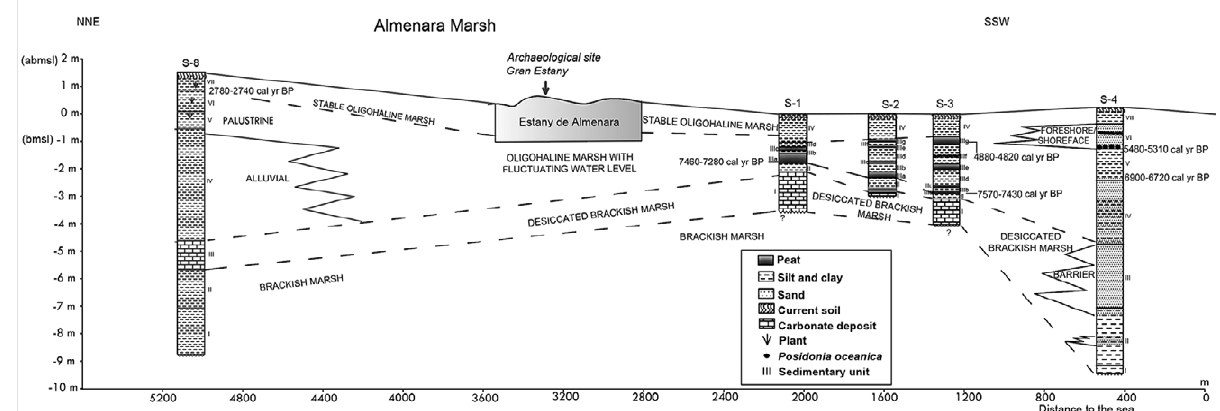
Fig. 6. – Correlation of cores S-1, S-2, S-3 and S-8 and proposed palaeoenvironmental